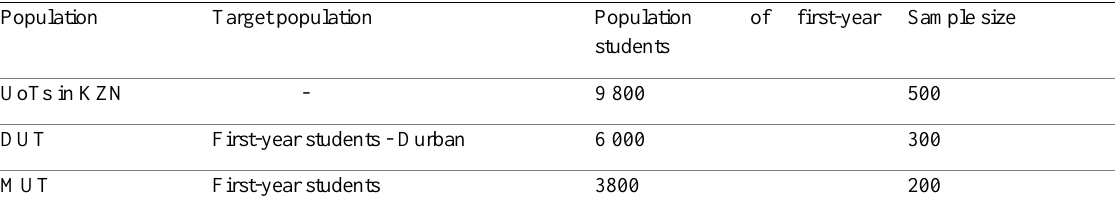
Table 1: Population, target population, and sample